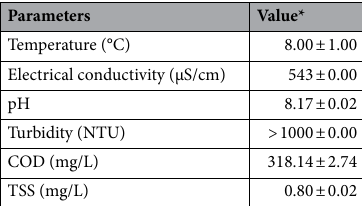
Table 2. Ceramic industry wastewater physicochemical characterization. *The value shows the mean of three